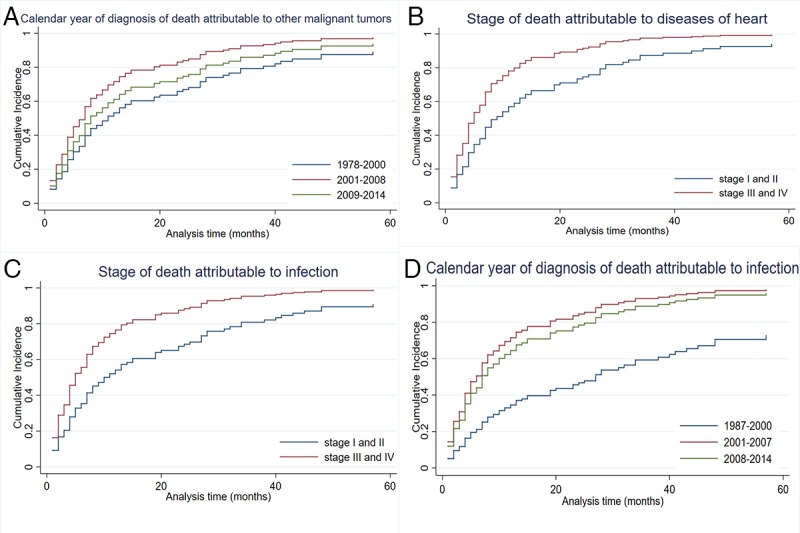
Cumulative incidence plot comparing (A) calendar year of diagnosis attribute to other tumors, (B) Ann Arbor stage of death attribute to disease of heart, (C) Ann Arbor stage of death attribute to infection and (D) calendar year of diagnosis attribute to infection.